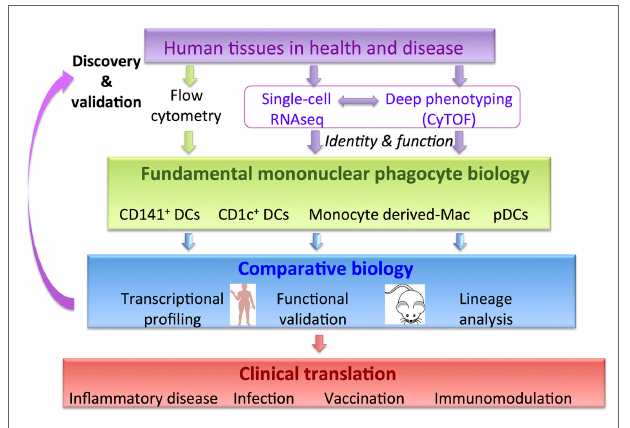
FiGURe 1 | Comparative biology is a validation and discovery tool to pull-through fundamental knowledge in MPS biology to clinical translation . Incorporation of new genomics and proteomics methodologies will accelerate